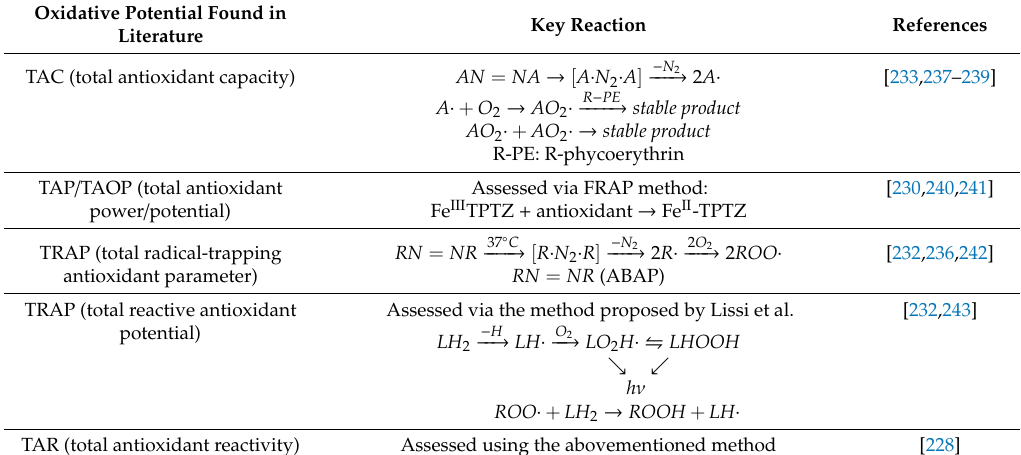
Table 3. Total antioxidant capacity with regards to the key reactions for their determination. Oxidative Potential Found in